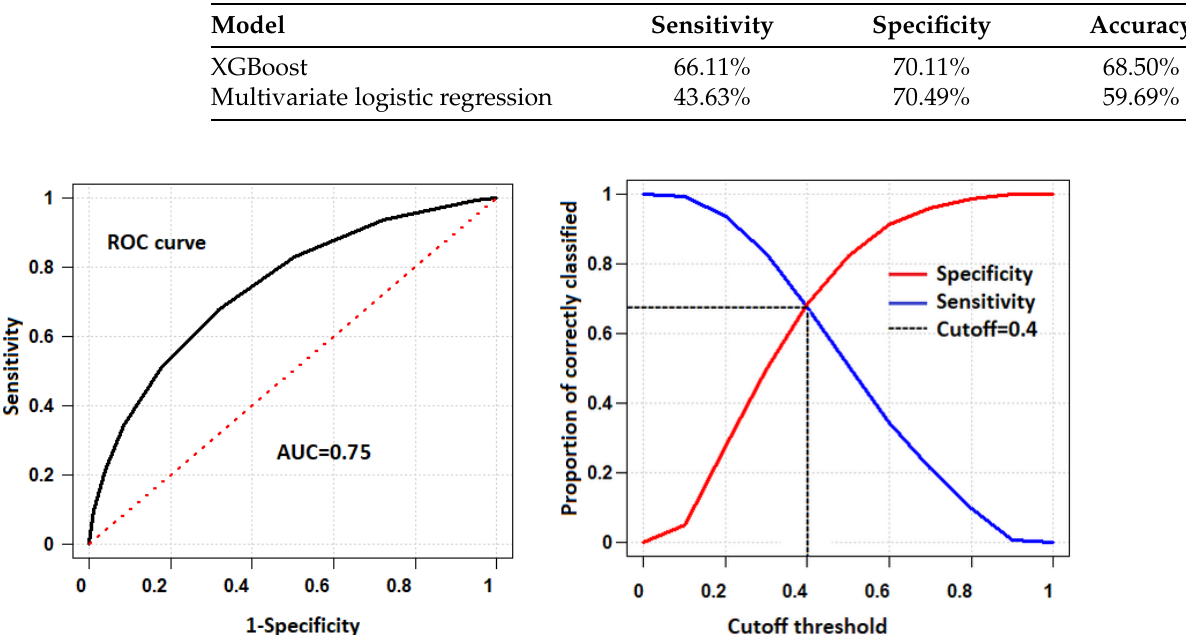
Table 4. Evaluation metrics of the XGBoost-LR and classic multivariate logistic regression models.